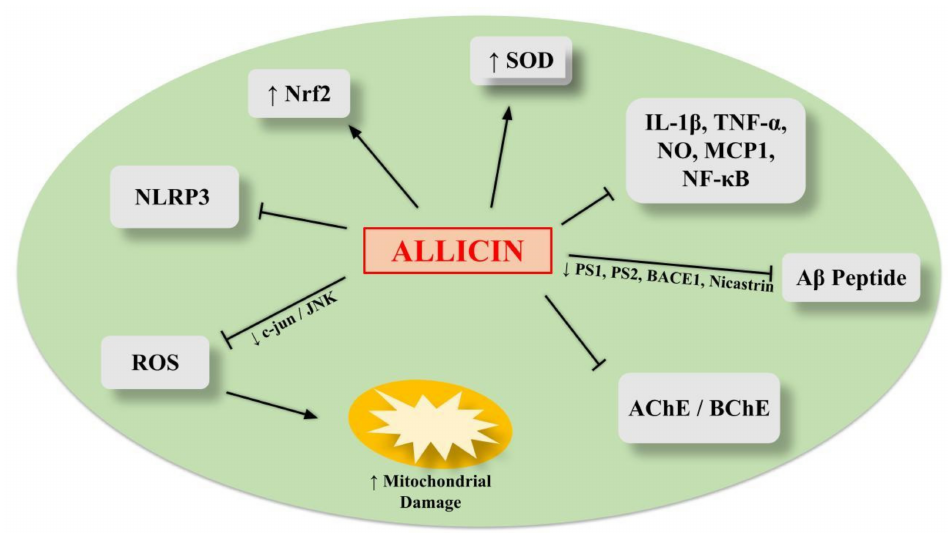
Figure 4. The main events induced by allicin to provide protection in AD.